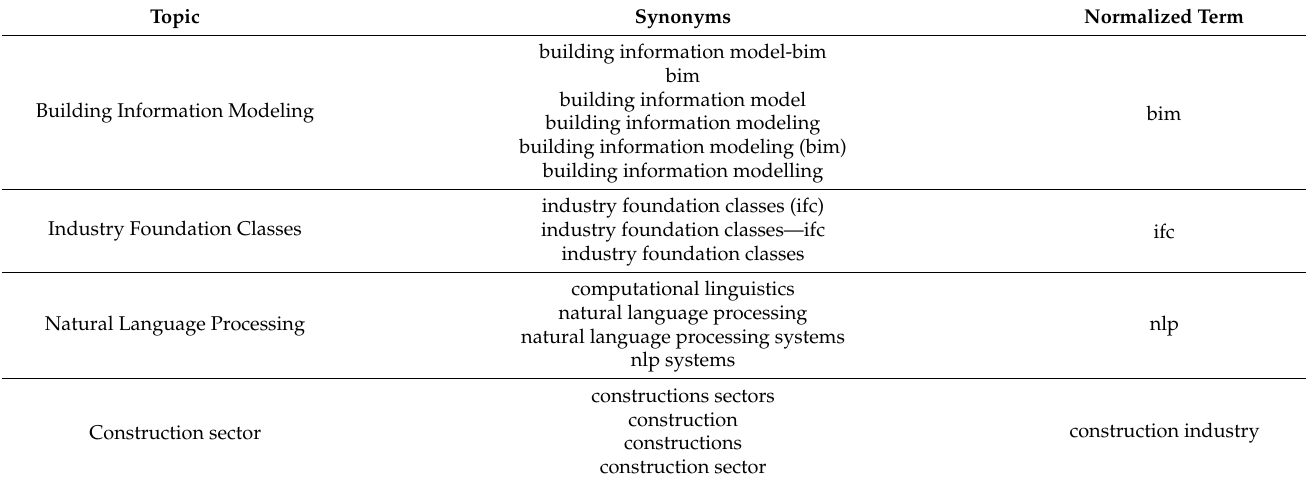
Table 2. Synonyms and lexical variants normalization.